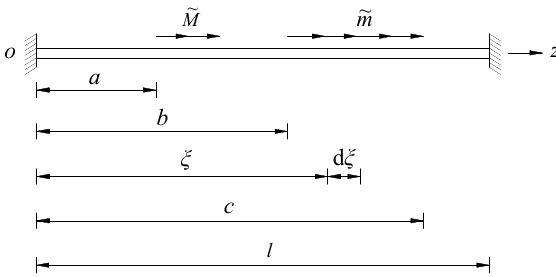
Figure 4. Schematic diagram of an applied torque action.